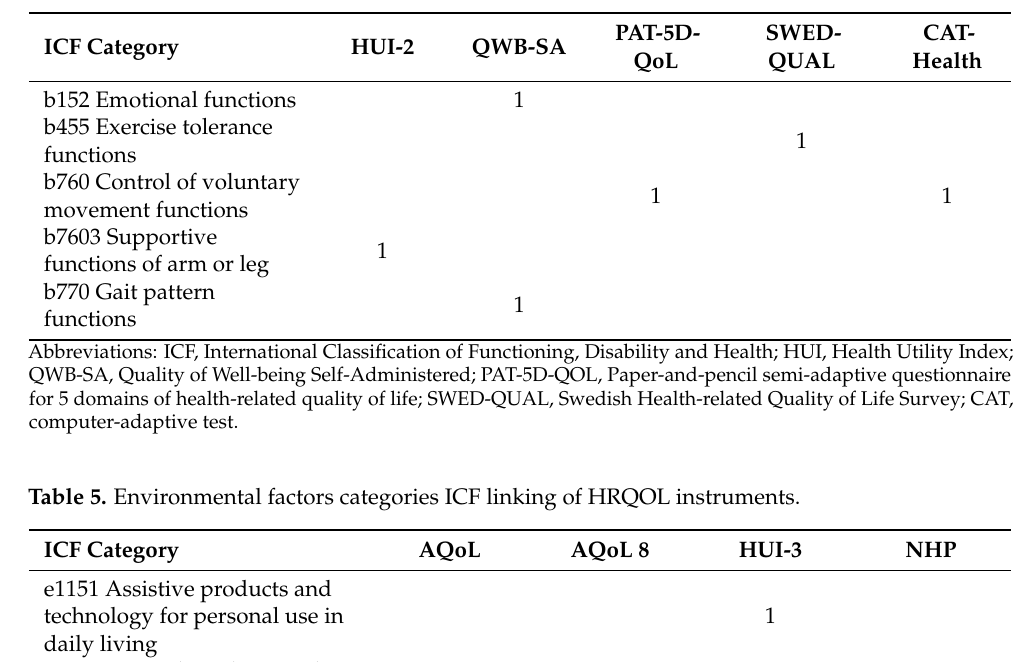
Table 4. Body functions categories ICF linking of HRQOL instruments.